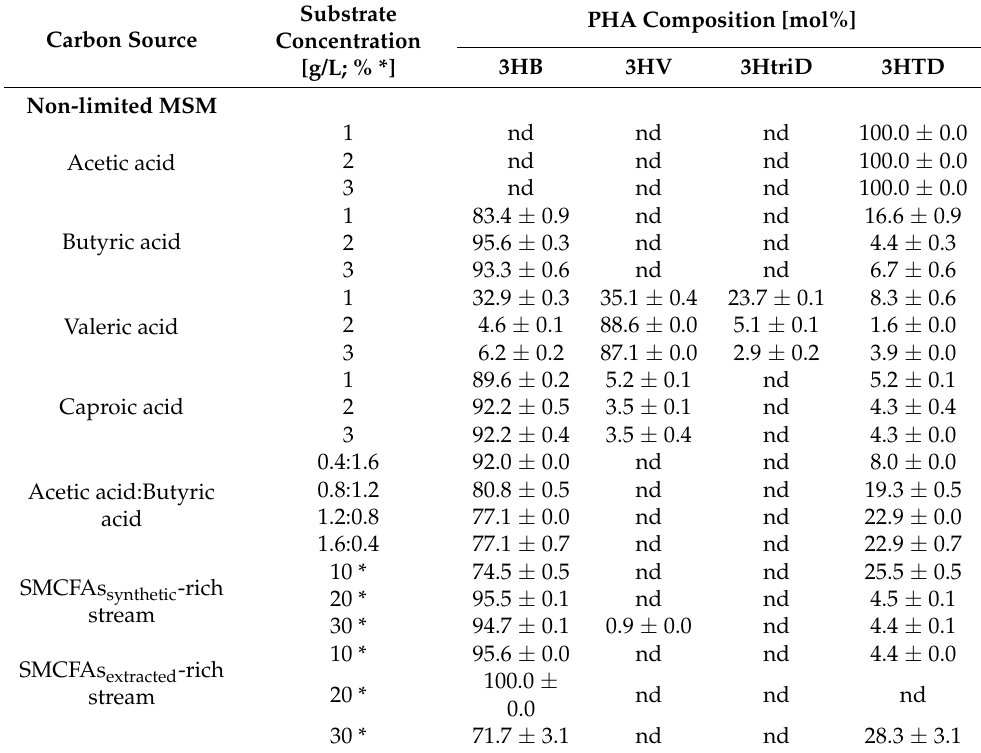
Table 3. Monomeric compositions of PHAs extracted from Aeromonas sp. AC_01